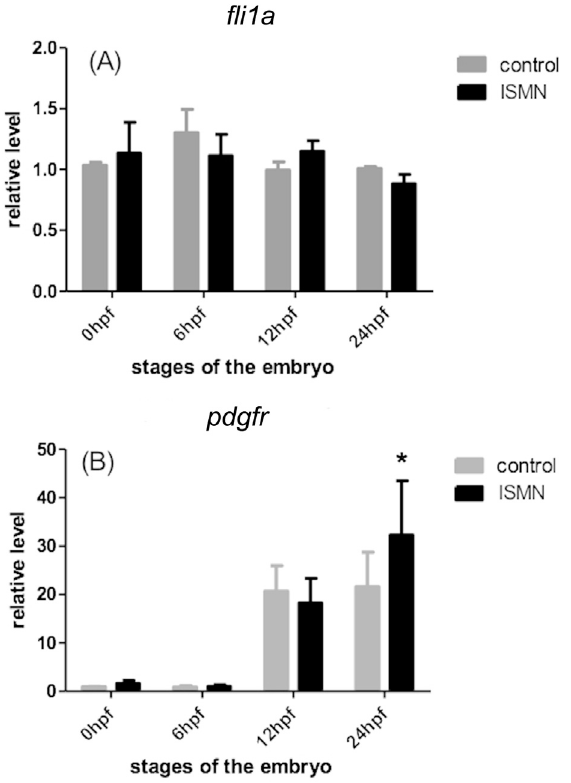
Figure 4 - Expressions of fli1a and pdgfr in zebrafish embryos treated with ISMN for 24 h. (A) fli1a expression. (B) pdgfr expression. Data were expressed as mean (cid:5) SD (n = 3). * p <